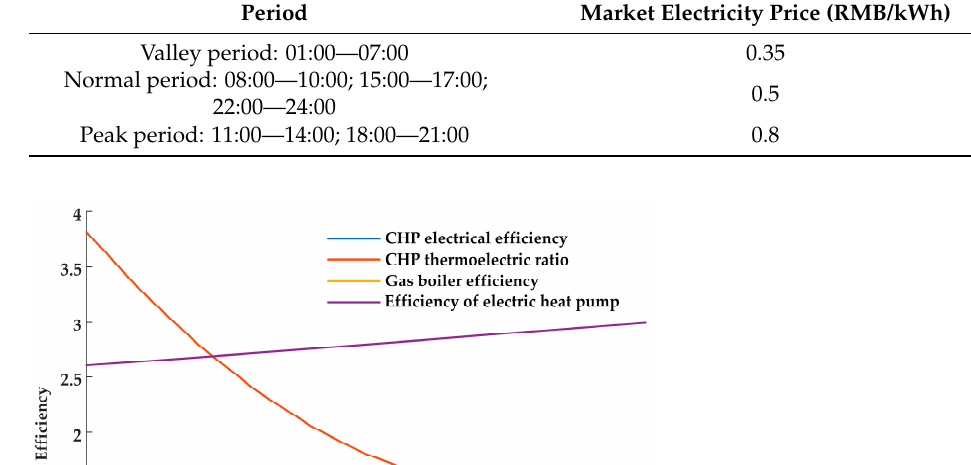
Table A3. Time of use electricity prices.